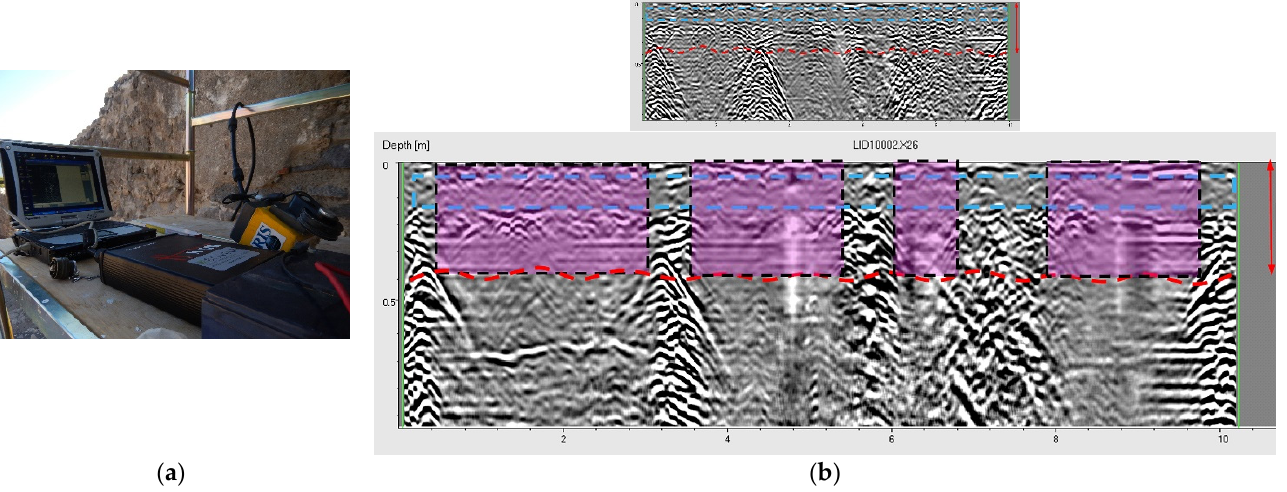
Figure 9. ( a ) Radar test on a structural wall: the equipment. ( b ) Comparison test before and after rehabilitation.